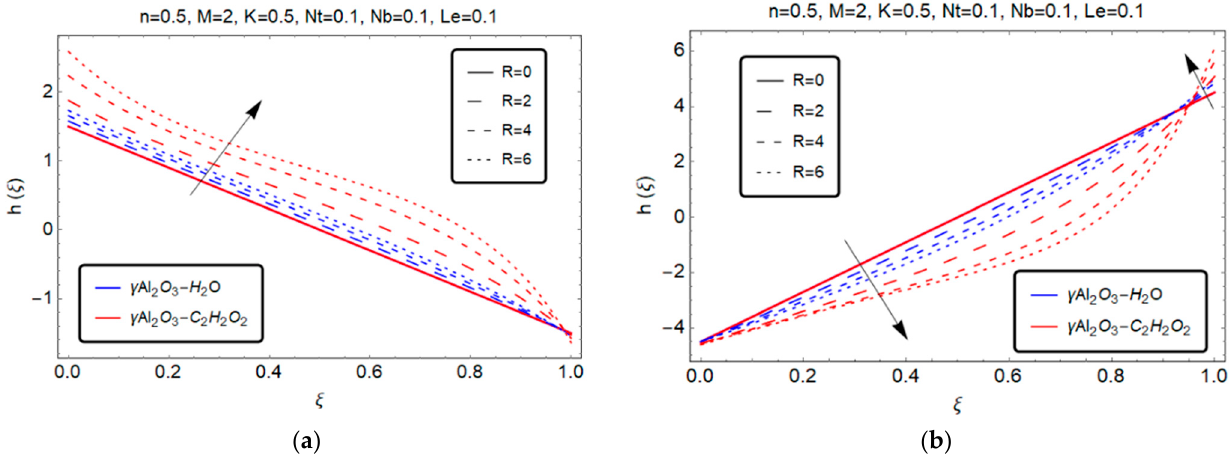
Figure 6. Effect of squeezed Reynold number 𝑅 on ℎ(𝜉) . ( a ) S > 0; ( b ) S < 0.